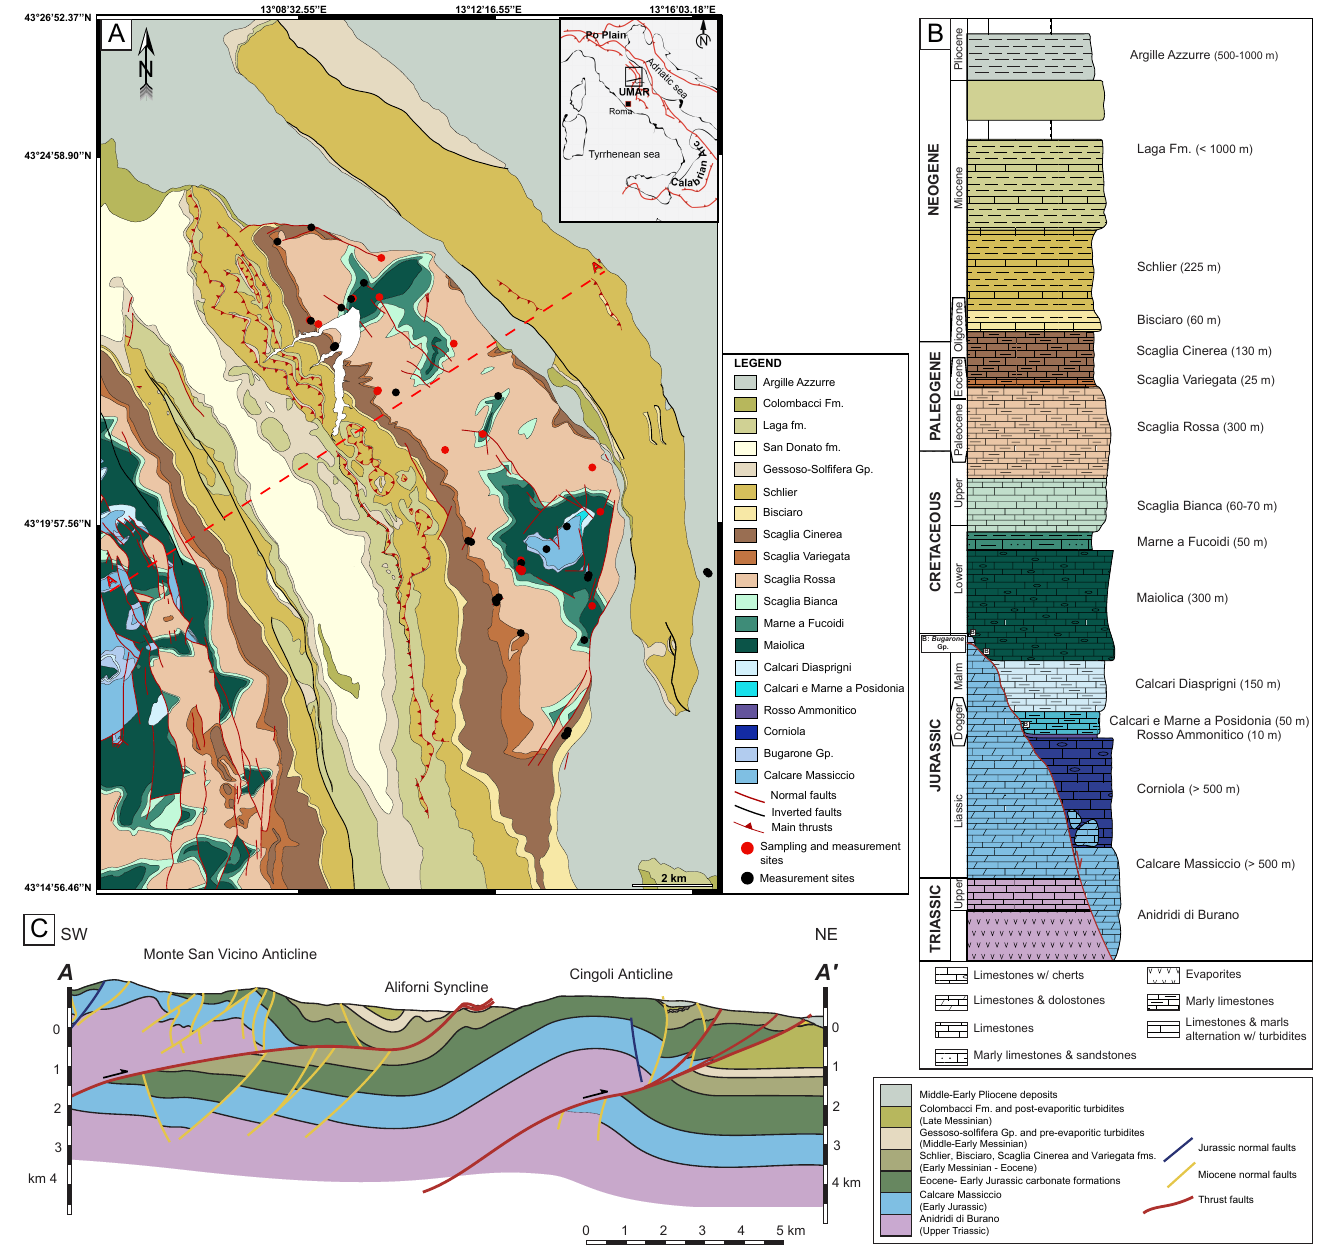
Figure 1. ( A ) Location and simplified geological map of the Cingoli Anticline. Red points represent the sampling sites for sedimentary stylolites analysis, and black points represent the measurement sites. ( B ) Stratigraphic column, not to scale, of the Umbria-Marche area, with thicknesses valid for the Cingoli Anticline area (modified from [61]). ( C ) SW-NE geological cross section through the northern part of the Cingoli Anticline